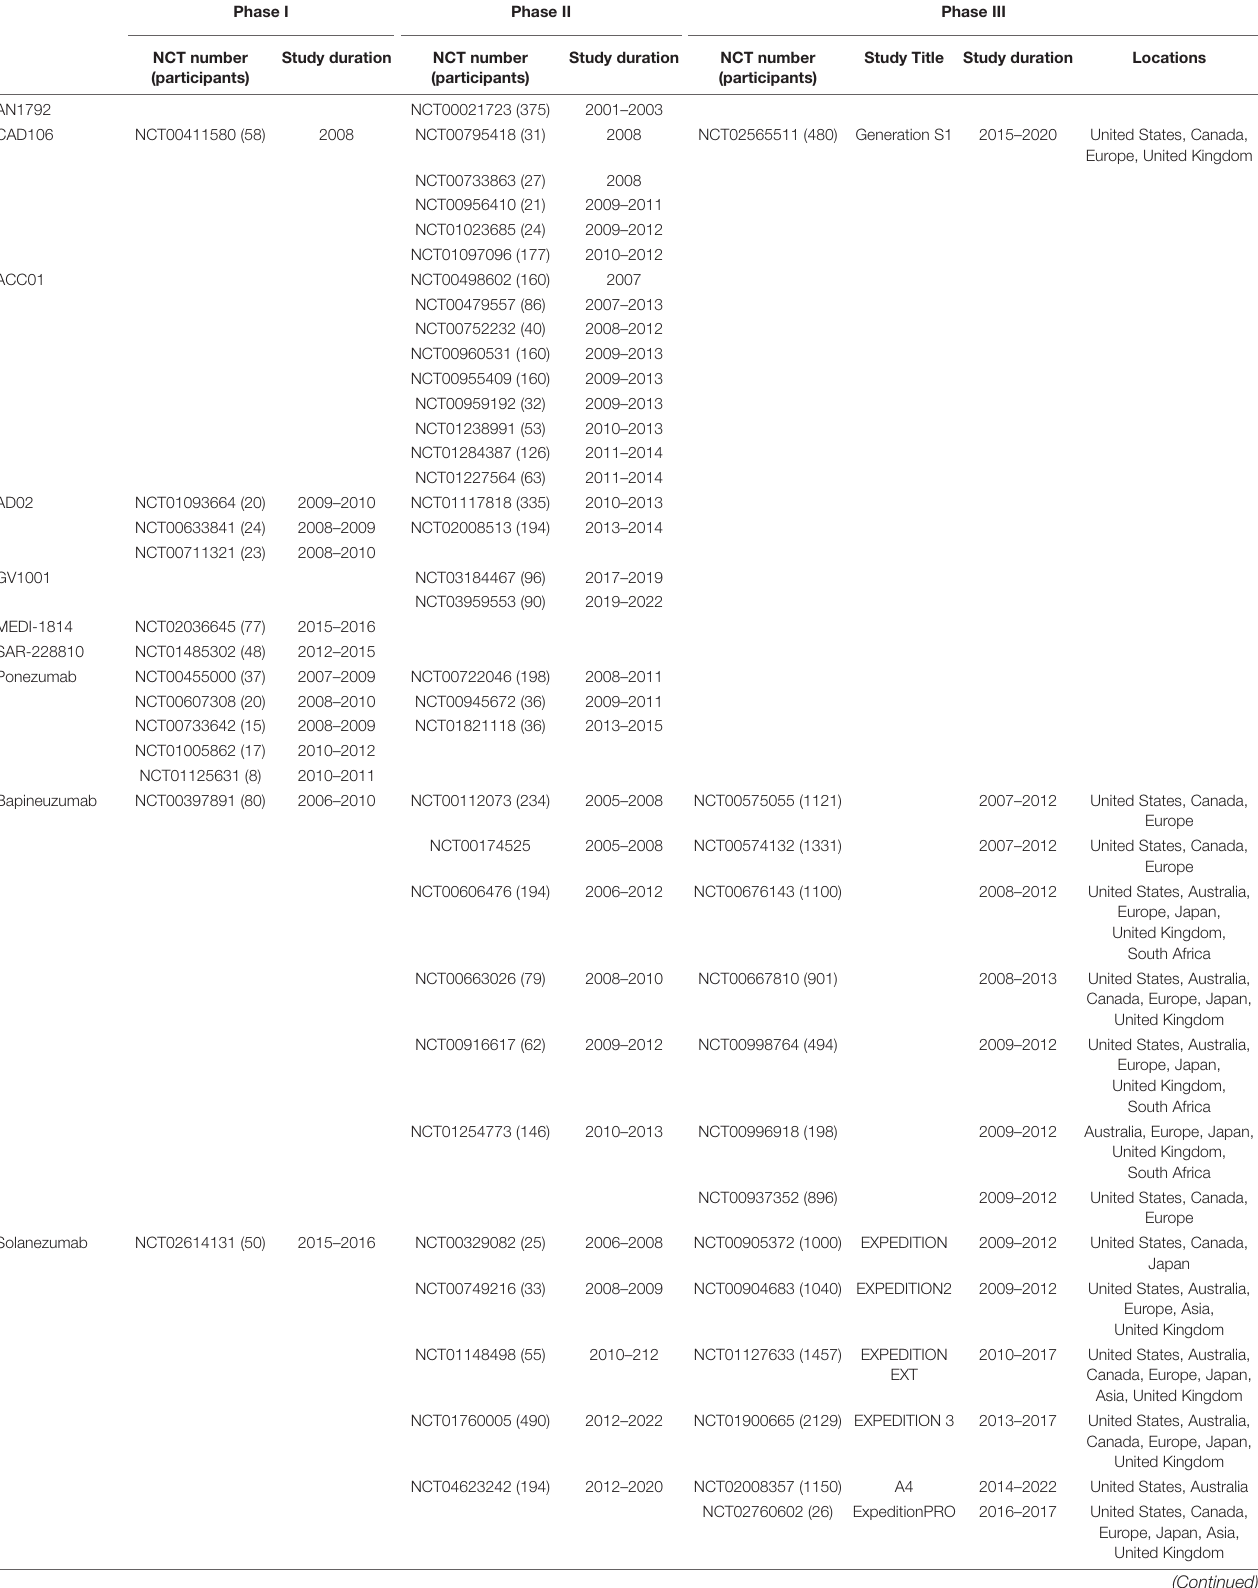
TABLE 1 | Summary of Clinical trials for passive and active immunotherapy in Alzheimer’s